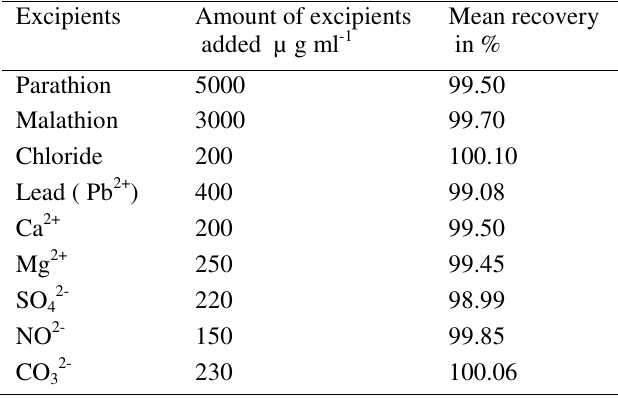
Table 2. Effect of excipients on the determination of